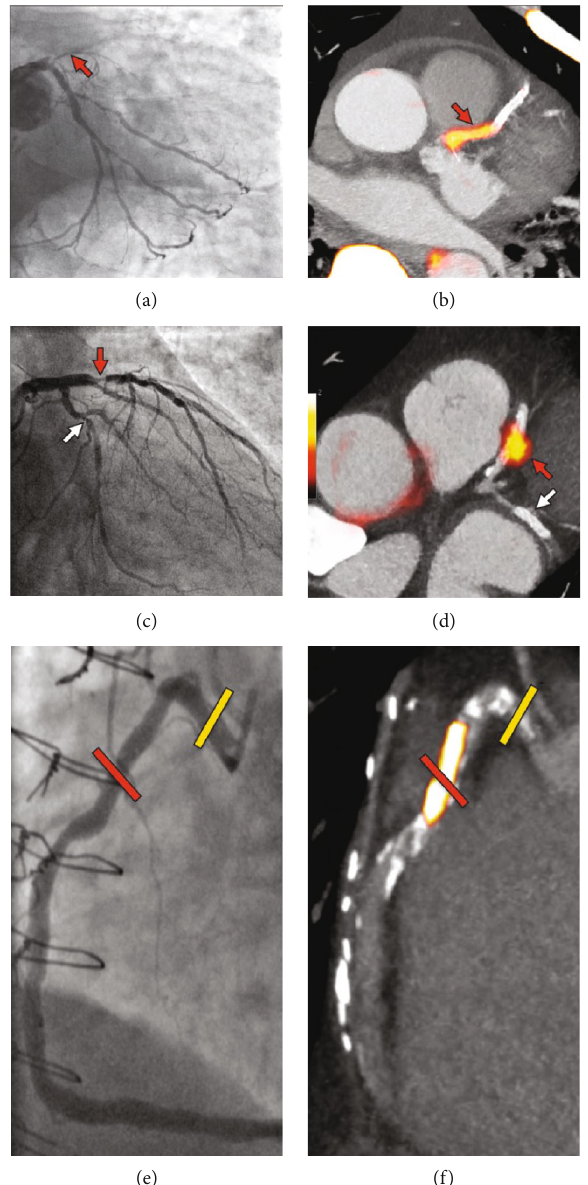
Figure 1: Focal 18 F-NaF in patients with myocardial infarction and stable angina. A patient with acute ST-segment elevation myocardial infarction with (a) proximal occlusion (red arrow) of the left anterior descending artery on invasive coronary angiography and (b) intense focal 18 F-NaF (tissue-to-background ratios, culprit 2.27 vs. reference segment 1.09 (108% increase)) uptake (yellow-red) at the site of the culprit plaque (red arrow) on the combined PET and CT. A patient with anterior non-ST-segment elevation MI with (c) culprit (red arrow; left anterior descending artery) and bystander nonculprit (white arrow; circum fl ex artery) lesions on invasive coronary angiography that were both stented during the index admission. Only the culprit lesion had increased 18 F-NaF uptake (tissue-to-background ratios, culprit 2.03 vs. reference segment 1.08 (88% increase)) on PET-CT (d) after percutaneous coronary intervention. In a patient with stable angina with previous coronary artery bypass grafting, (e) invasive coronary angiography showed nonobstructive disease in the right coronary artery. (f) Corresponding PET-CT scan showed a region of increased 18 F-NaF activity (positive lesion, red line) in the midright coronary artery (tissue-to-background ratio, 3.13) and a region without increased uptake in the proximal vessel (negative lesion, yellow line). This fi gure was originally published in the Lancet under